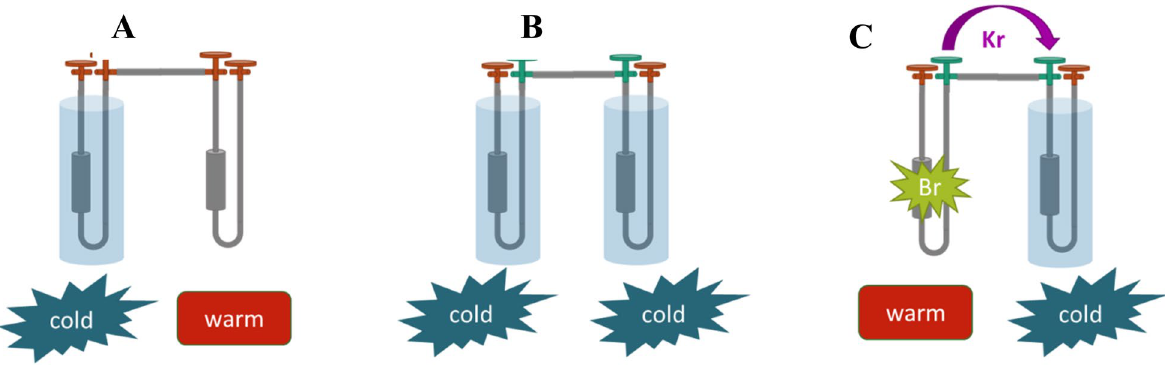
Figure 3. ( A ) The initial trap is cold, and the receiving trap is warm. ( B ) Both traps are cold and the valves between them are opened to allow gas transfer. ( C ) The initial trap is warmed, forcing gas into the receiving trap. In this process, the daughter 76/77 Br isotopes would remain in the initial trap and the parent 76/77 Kr isotopes would transfer to the receiving